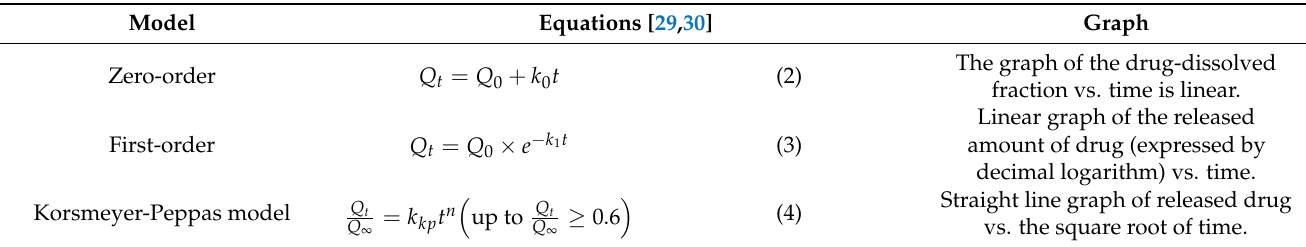
The graph of the drug-dissolved fraction vs. time is linear. Linear graph of the released amount of drug (expressed by decimal logarithm) vs. time. Straight line graph of released drug vs. the square root of